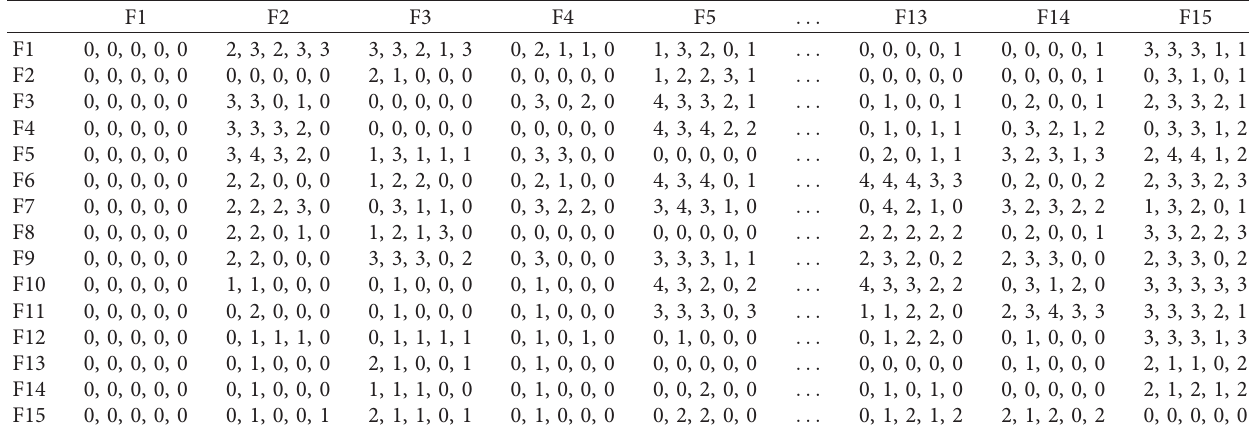
Table 2: The group direct-relation matrix of 5 experts.